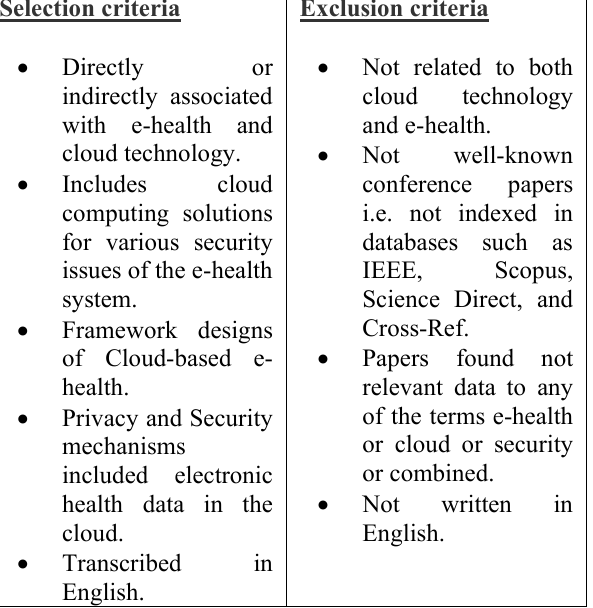
from different search engines for the review.